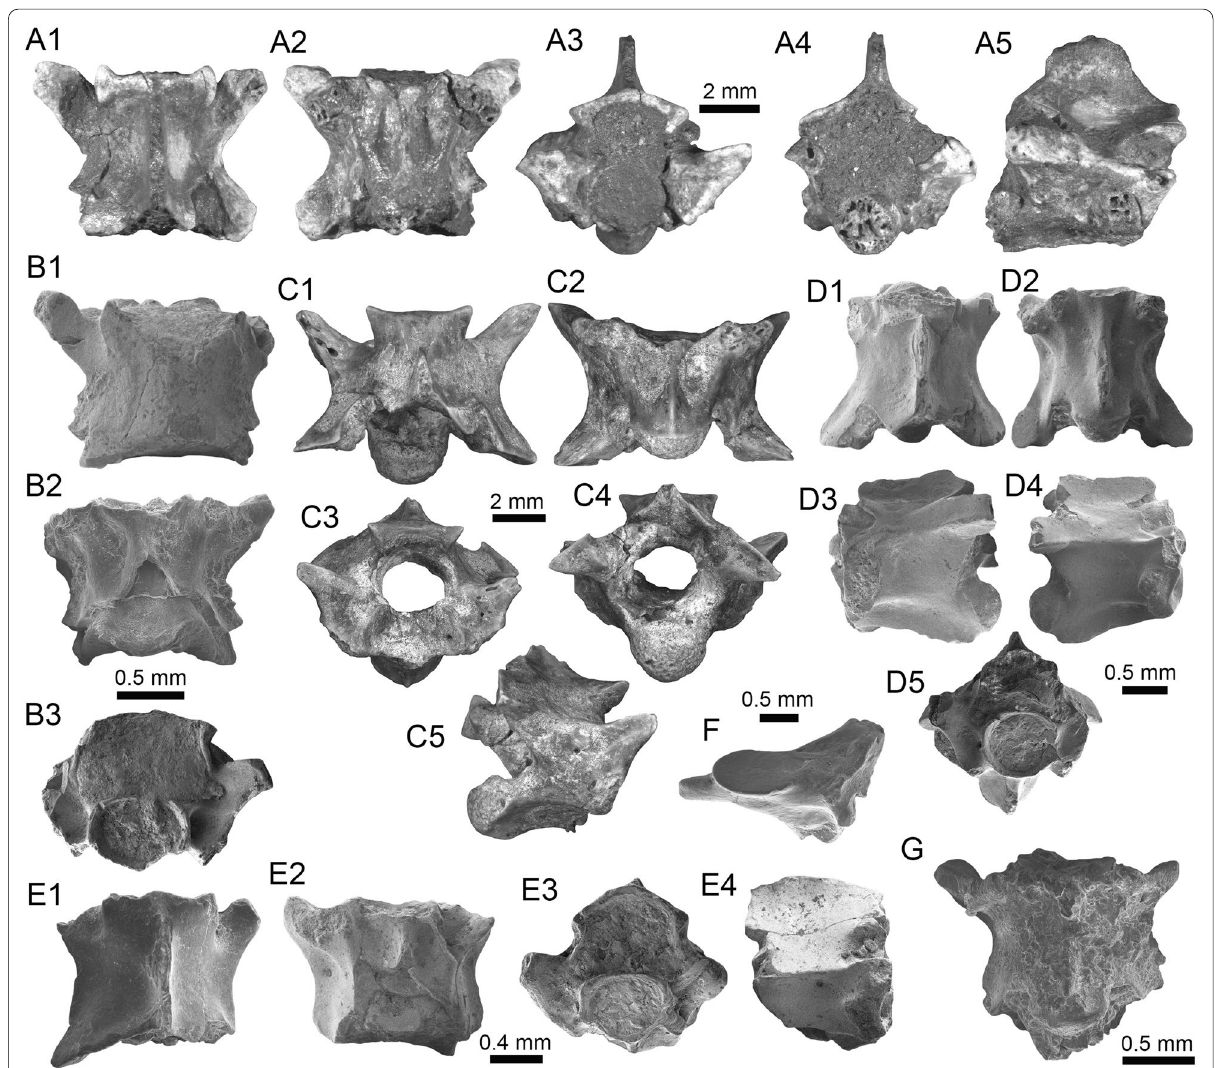
Fig. 18 Serpentes (Boidae and Colubroides) from the Vergel Member. A1 – B3 Trunk vertebra ( A1 – A5 AMU‑CURS‑1147) and specimen of indeterminate position ( B1 – B3 AMU‑CURS‑804) of Boidae indet. C1 – C5 Trunk vertebra of ?Boidae or ?Aniliidae indet. (AMU‑CURS‑1158). D1 – D5 Trunk vertebra of Colubroides indet. (AMU‑CURS‑1161). E1 – G Trunk vertebra ( E1 – E4 AMU‑CURS‑803), fragmented prezygapophysis ( F AMU‑CURS‑724), and a trunk vertebra ( G AMU‑CURS‑805) of Serpentes indet. Views: anterior ( A3 , B3 , C3 , D5 , E3 ), dorsal ( A1 , B1 , C1 , D1 , E1 ), left lateral ( D3 ), right lateral ( A5 , C5 , D4 , E4 ), posterior ( A4 , C4 ), and ventral ( A2 , B2 , C2 , D2 , E2 , G